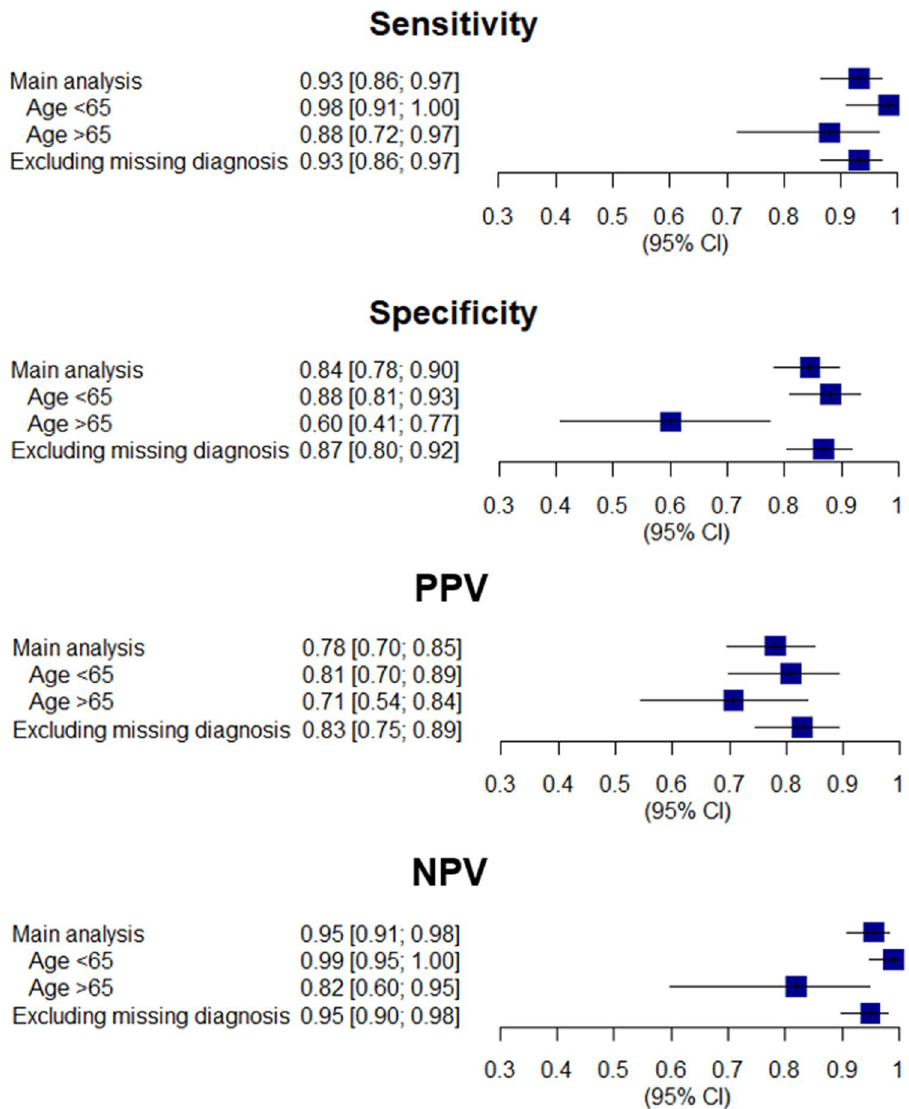
Figure 3. Estimations of the fourth algorithm in the three analyses. The fourth algorithm was made up of RA according to hospital discharge records or emergency department admissions (ICD-9 code, 714*) OR RA according to exemption code from co-payment (006). Sensitivity (percentage of patients rightly classified as having rheumatoid arthritis (RA) by the algorithm within the RA patients); specificity (percentage of patients rightly classified as non-having RA by the algorithm within non-RA patients); positive predictive value (percentage of patients rightly classified as RA by the algorithm within all patients classified as RA by the algorithm) and negative predictive value (proportion of patients rightly classified as non-RA by the algorithm within all patients classified as non-RA by the algorithm) were calculated in the three analyses. The main analysis included all patients in the reference sample even those with missing diagnosis, classified as non-RA patients. The first sensitivity analysis excluded patients with missing diagnosis in the reference. The second sensitivity analysis stratified patients according age into two groups: patients under 65 years old and patients over 65 years. 95% CI 95% confidence interval, NPV negative predictive value, PPV positive predictive value, RA rheumatoid